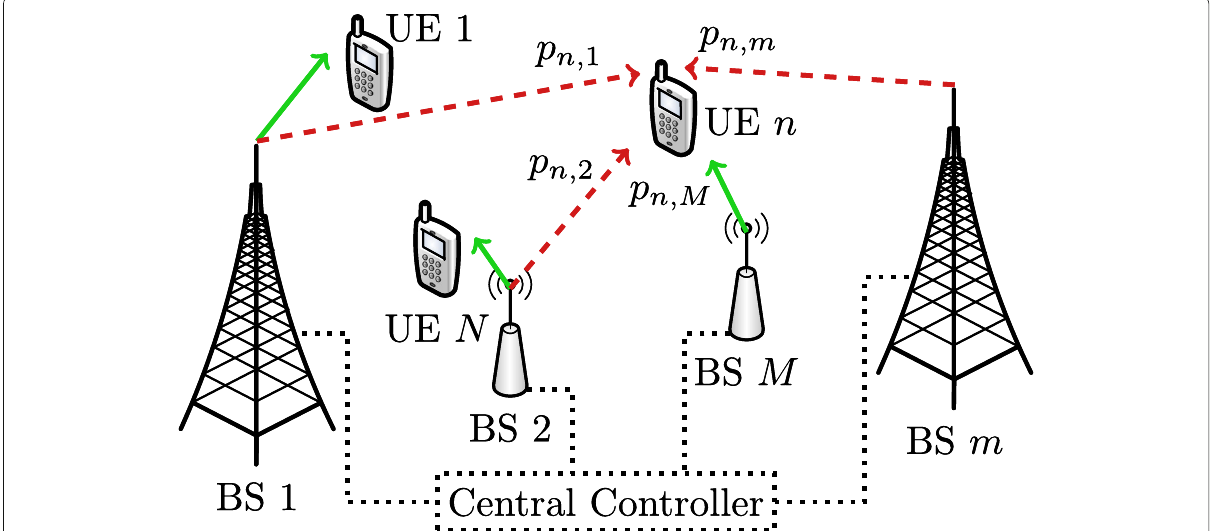
Fig. 1 Cooperation cluster of M BSs and N UEs in the downlink. The BSs are connected through the backhaul to a central